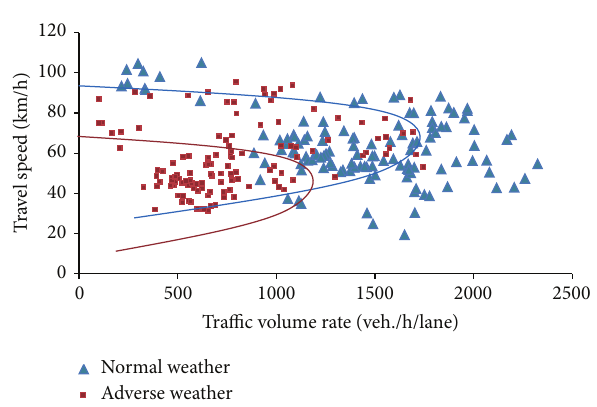
Figure 2: Observed speed-flow rate scatter diagram under various weathers. Note: the two regression lines in the figure are just the sketch